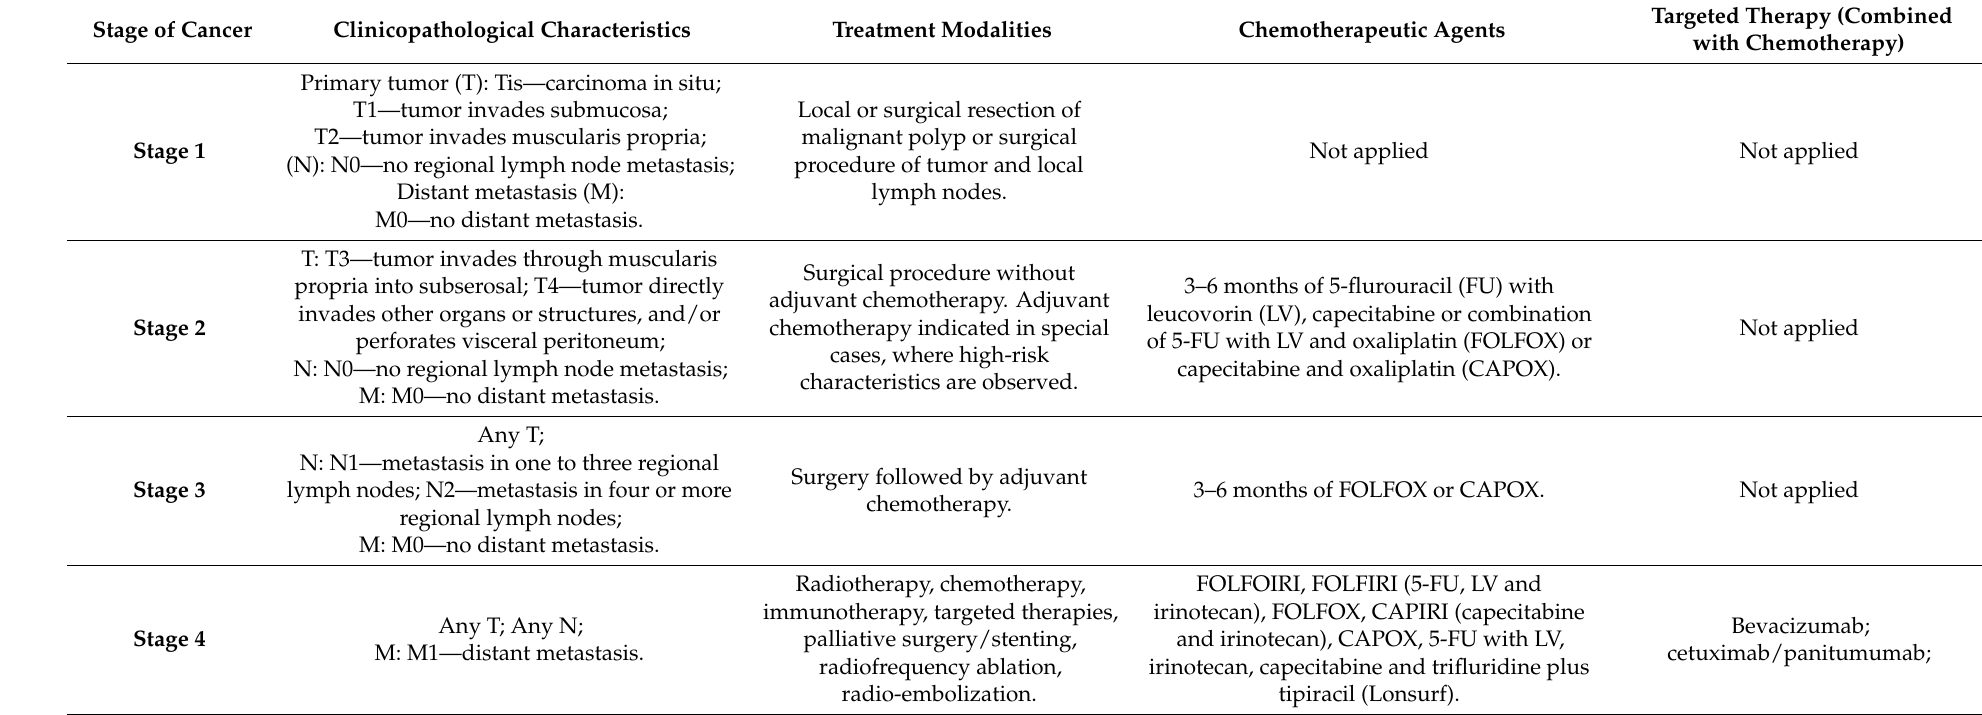
Table 1. Most common treatment options based on the stage of colorectal cancer (excluding rectal cancer) using the TNM classification. Stage of